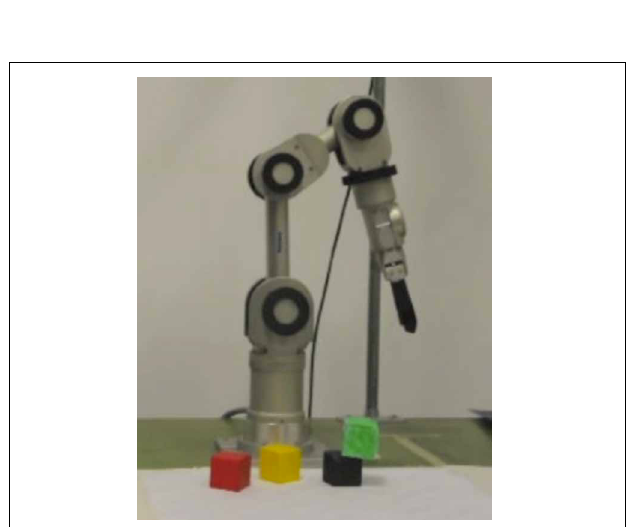
FIGURE 14 | A “tricky” situation to test the robot’s stacking skill. We show this case to illustrate the value of exploring to learn how the world works. Consider the robot is faced with a task to build a stack of blocks as fast as possible from this initial setting. Given its learned model of the world, the robot will decide to start stacking from height 1 instead of height 2, as with high probability the stack of two blocks will fall after placing another block upon